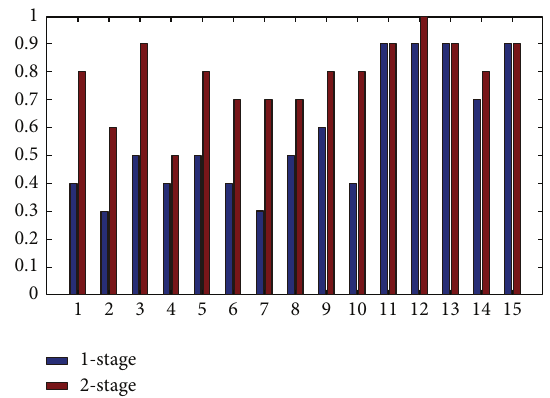
Table3:Averageestimationerrorwithvaryingilluminationundera series of poses. ± 90 ∘ , I-2-H, indicates horizontal (H) (V for vertical) changes from − 90 ∘ to 90 ∘ with 2 ∘ increments (I).